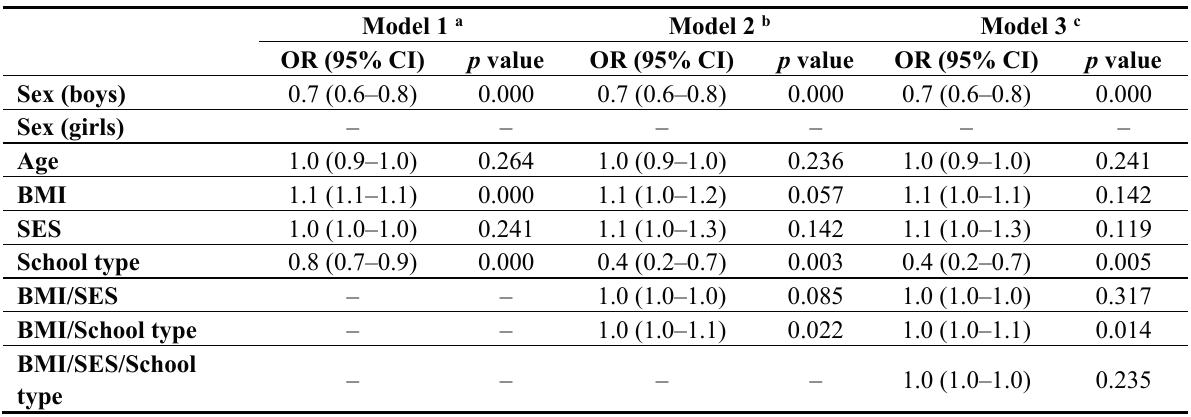
Table A1. Results of the multivariable logistic regression models with SRH as dependent variable, adjusted for sex and